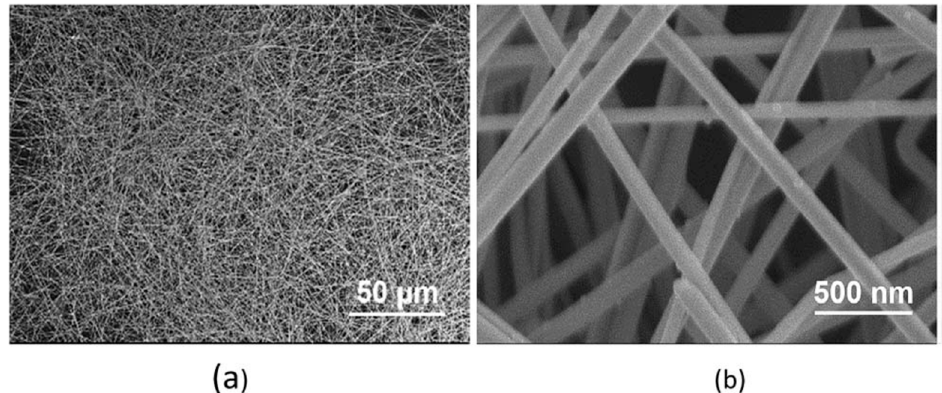
Figure 2. Microlevel images of long AgNWs prepared by the one-step polyol method ( a ) at 50 µm scale and ( b ) at 500 nm scale. Reprinted with permission from Ref. [59]. Copyright 2019, Royal Society of Chemistry.